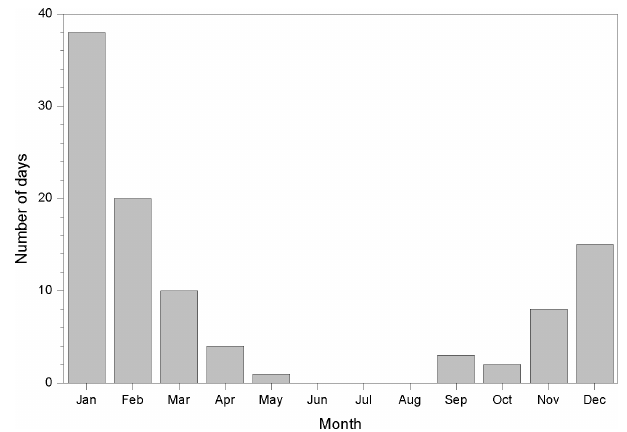
Figure 3. Monthly variation in the number of NPF days between March 2009 and December